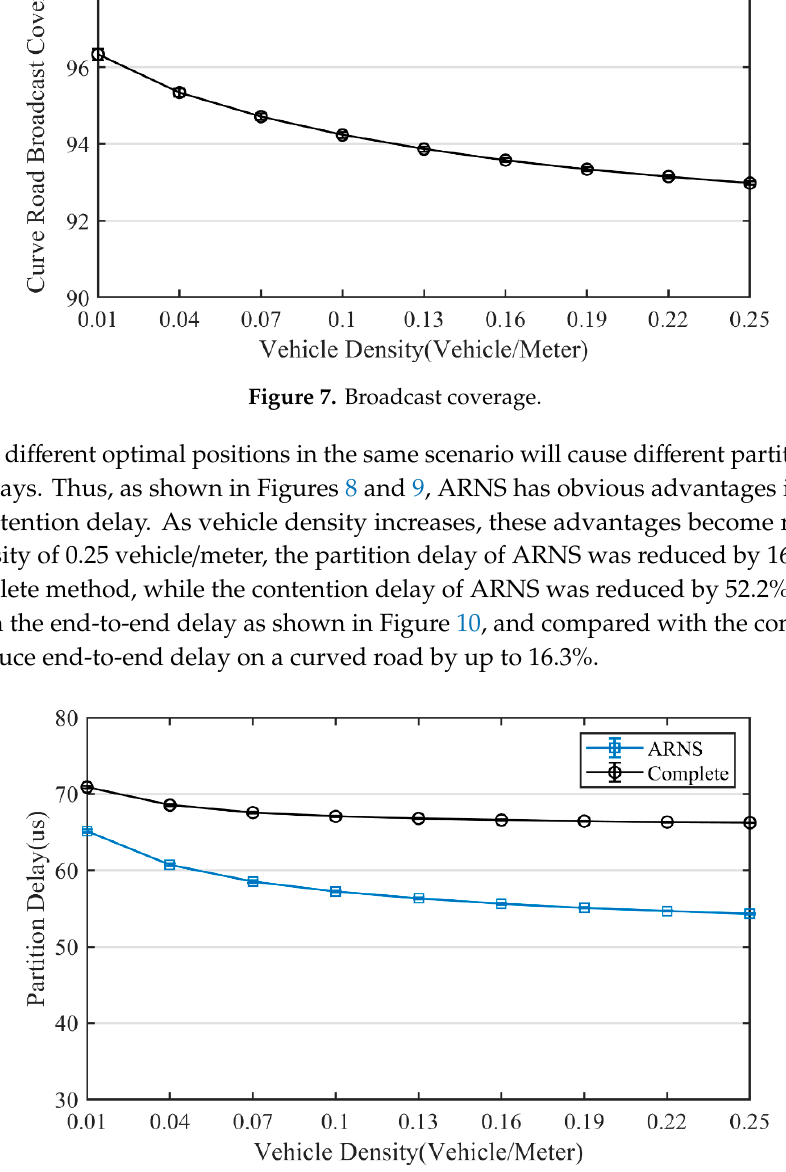
Figure 8. Partition delay.